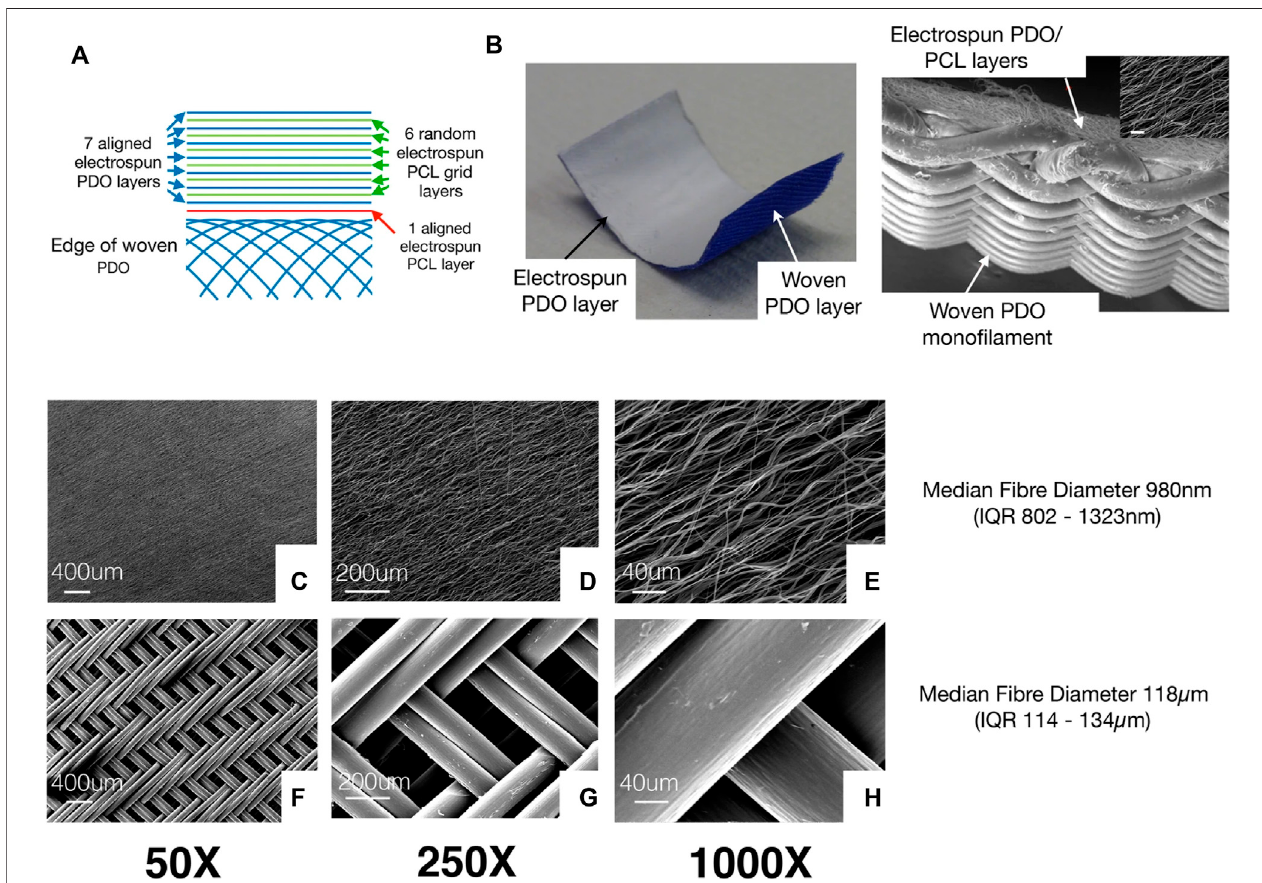
FIGURE 5 | (A) Figure shows the different layers in the electrospinning patch. The electrospinning assembly of the patch consists of seven layers of aligned electrospunPDO fi berssandwiched alternatelybetween6layersofthinPCLelectrospinningmesh(usedasabinder).AsinglelayerofalignedelectrospinningPCL fi